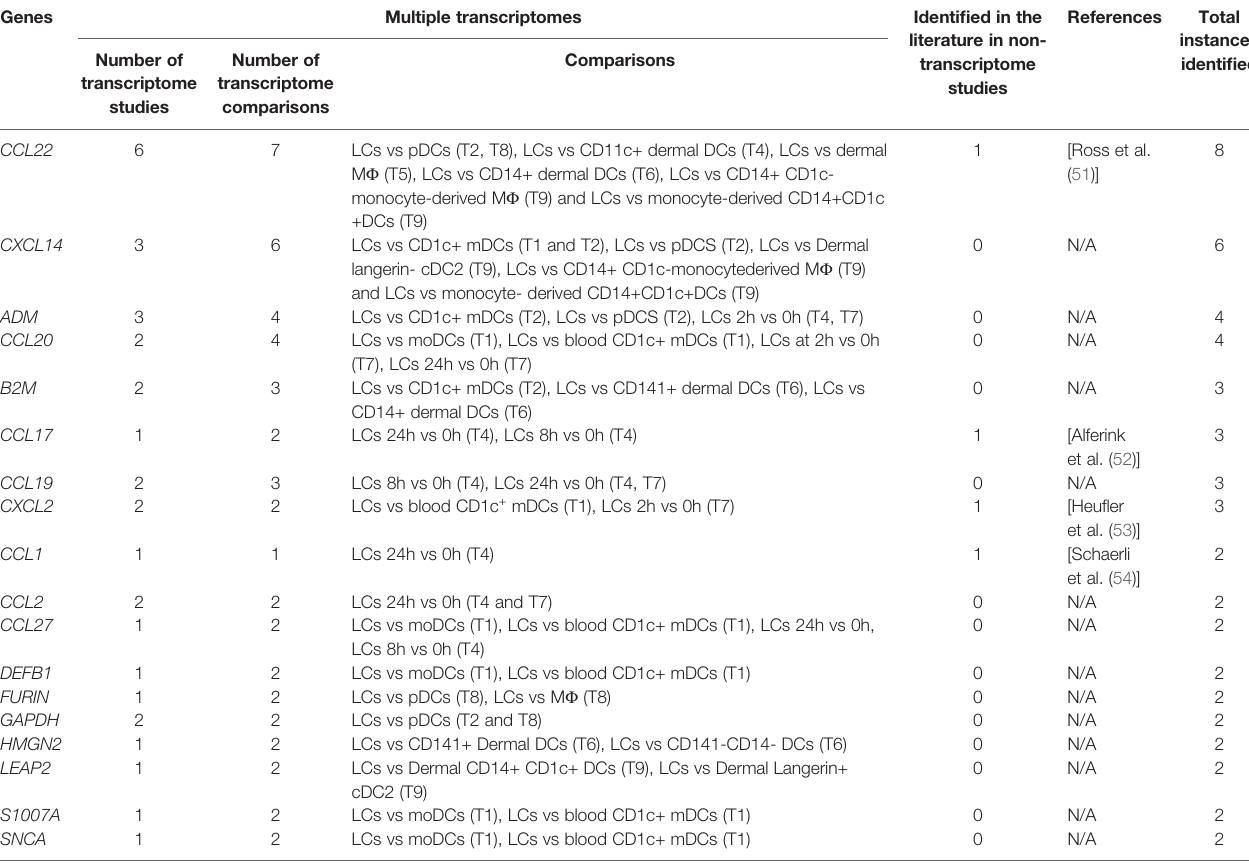
TABLE 1 | Identi fi cation of genes encoding peptides with antimicrobial activity in LCs in transcriptome studies.